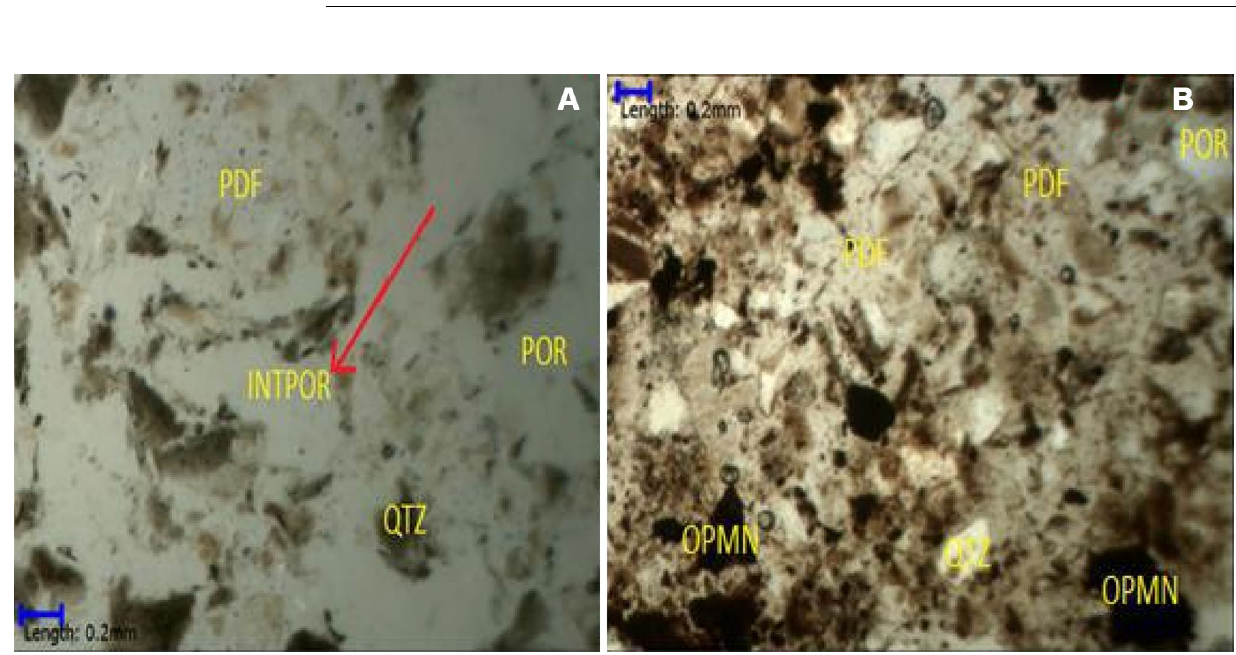
Fig. 10 a, b Feldspar grain particularly orthoclase in Araromi-Obu/ Ago-Alaye at depth 60–63 m and 75–78 m, respectively, under crossed polarised light (i.e. nicol). INTPOR interconnected pore